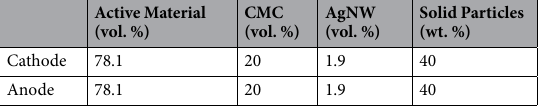
Table 3. Prepared cathode and anode composite